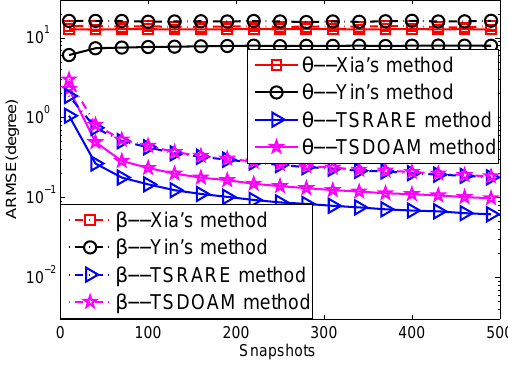
Figure 4. The ARMSE versus